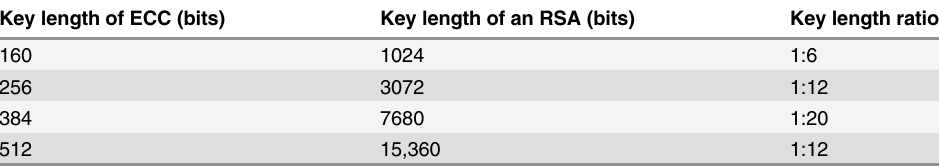
Table 1. Comparison of the key length between RSA and ECC on the same security level. Key length of ECC (bits) Key length of an RSA